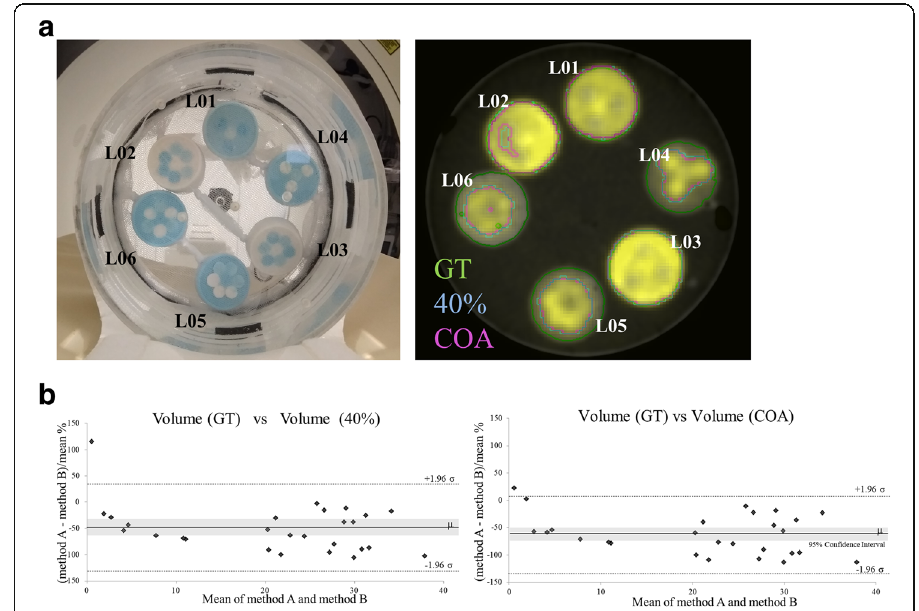
Fig. 7 Heterogeneous simulated lesions. a Images and contours resulted from the 3 segmentation methods: a density threshold in the corresponding CT (ground truth), the 40% threshold PET segmentation approach (40%), and the contrast-oriented algorithm (COA). b Bland – Altman plot analysis for